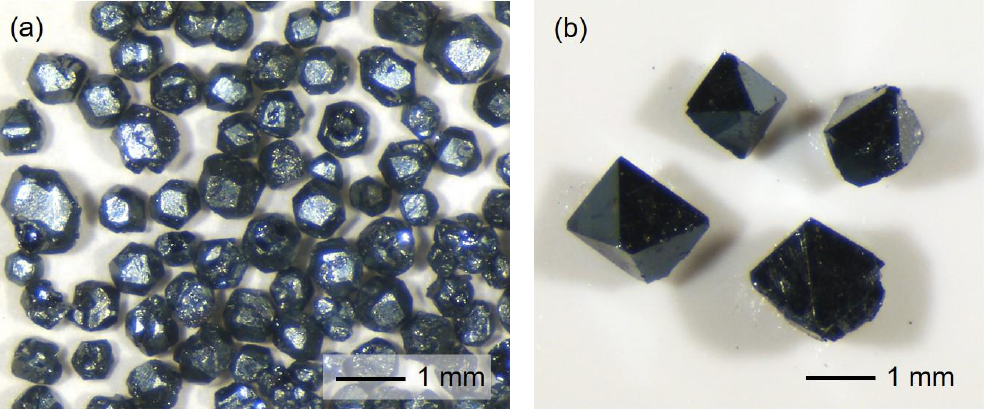
Figure 1. Optical micrographs of ( a ) type-I and ( b ) type-II Na – Si clathrate single crystals obtained by heating Na 4 Si 4 and Na 9 Sn 4 at 823 K for 12 h, followed by alcohol and acid treatments.